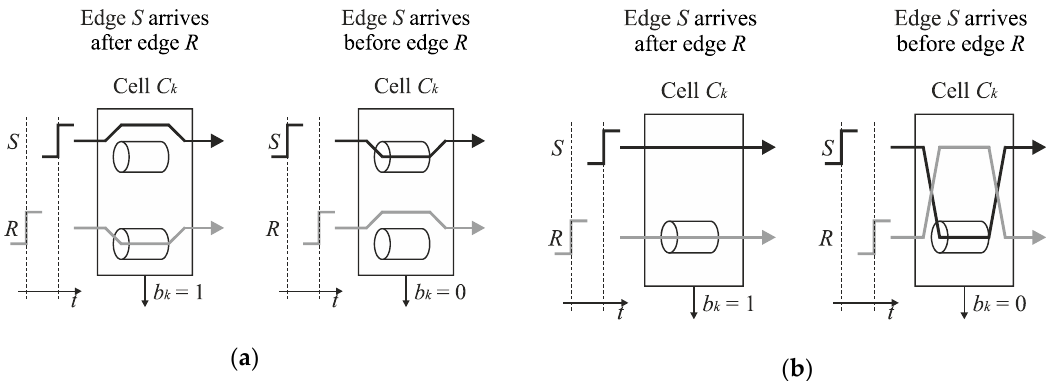
Figure 15. Illustration of the use of delay lines in feedforward SA-TDC architecture ( a ), and a concept of SA-TDC architecture with a single delay line in each cell ( b ).